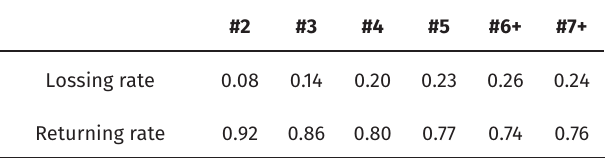
The expected losing rate depends on the range of shot number used in the calculation; 0.18 is calculated from the second shot and after, and 0.21 is calculated from the third shot and after. Table 1. A sample of observed losing rate and returning rate for different shot numbers.